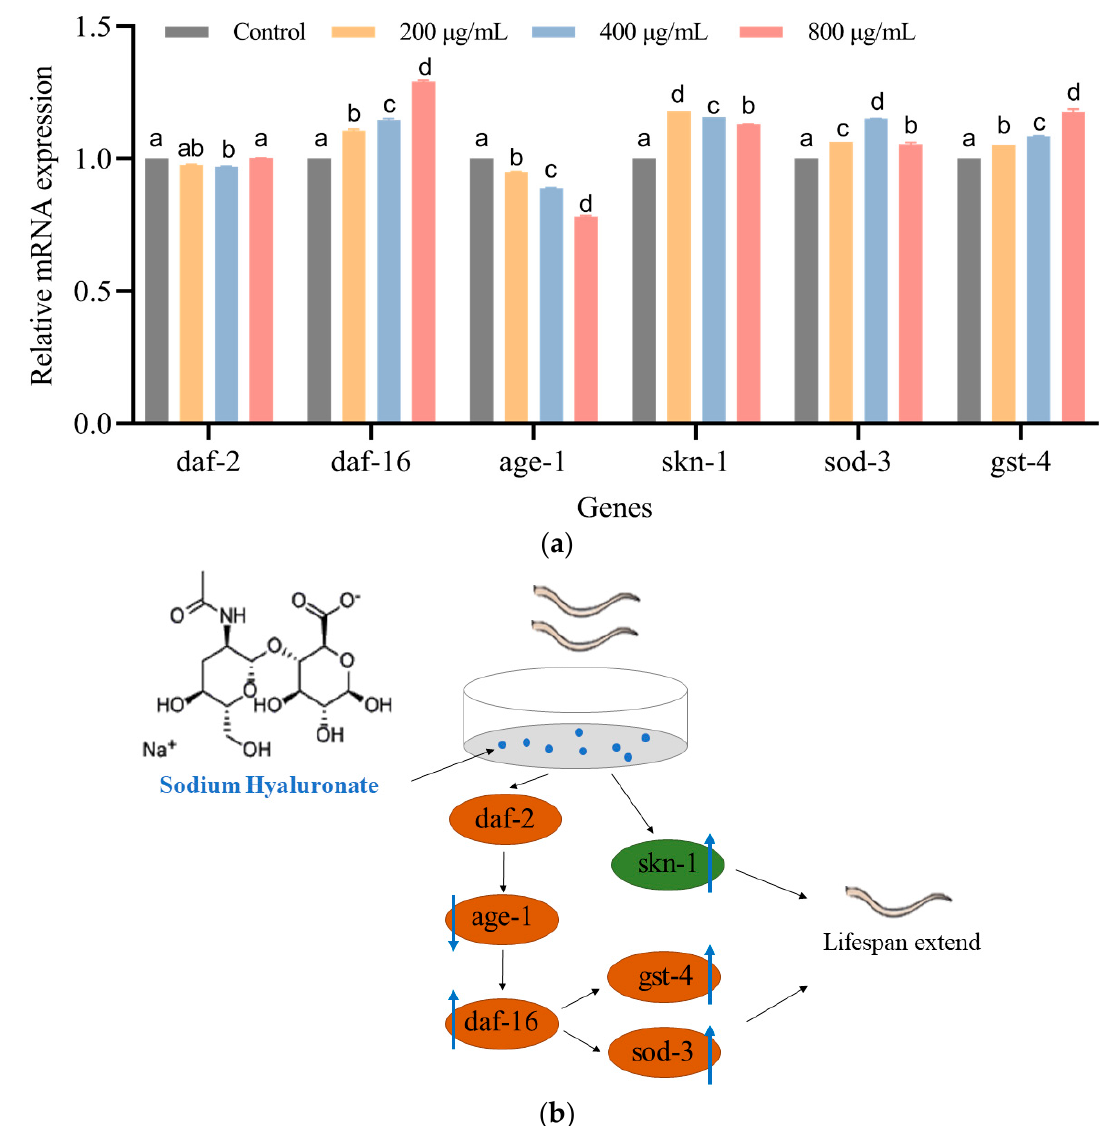
Figure 5. ( a ) Effect of SH on the expression of C. elegans -related genes. ( b ) Possible molecular mechanism of the anti-ageing effect of SH. Data are shown in mean ± SD, n = 3. Notes: no common letter in the same gene column indicates a significant difference ( p < 0.05). Additionally, ns represents not